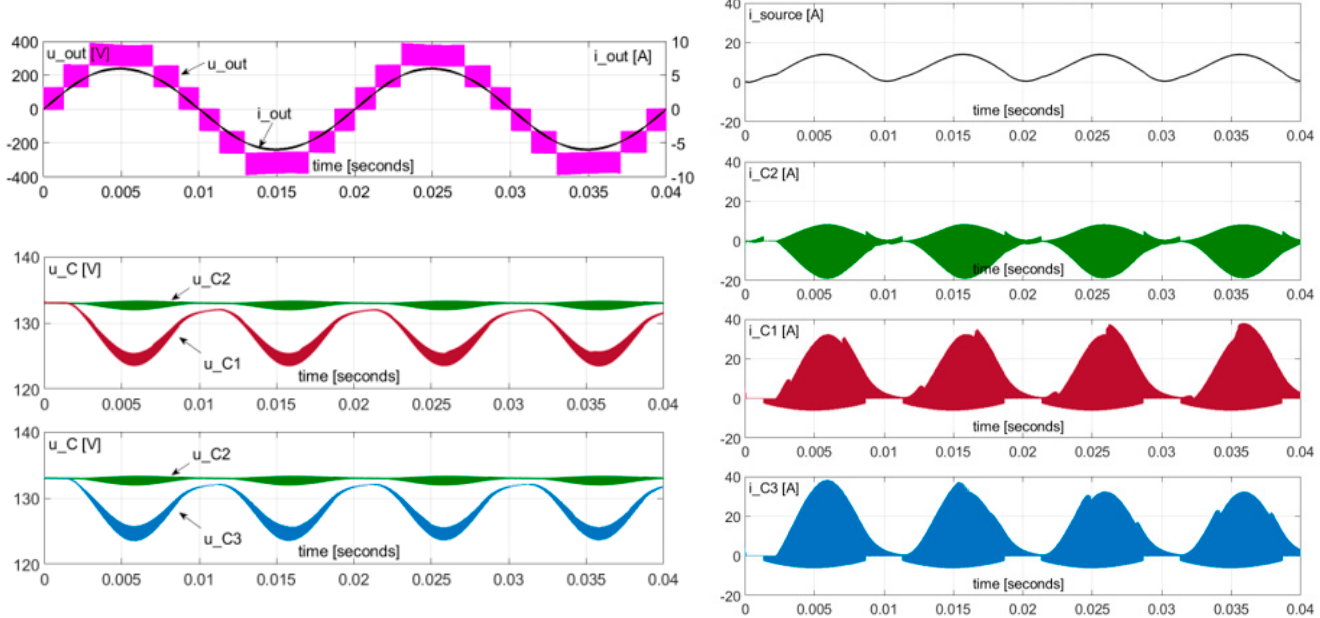
Figure 7. Steady state waveforms of DC-AC system (Figure 1) with the AIVB operating with constant frequency. The output voltage, the load voltage and current, voltages and currents of DC-link capacitors and the source. 5 ms/div, P out = 1 kW, L f = 6 uH.